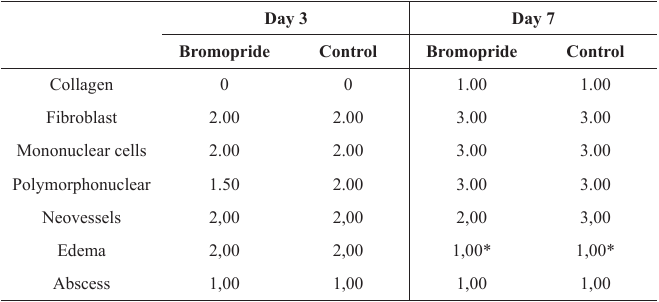
TABLE 3 - Median of the results of the histopathological analyzes. The variables collagen, fibroblast, mononuclear cells, polymorphonuclear cells, neovessels and edema were graduated from 0, absense, to 3, high presence. The variables abscess was graduated from 0, absent, to 1,